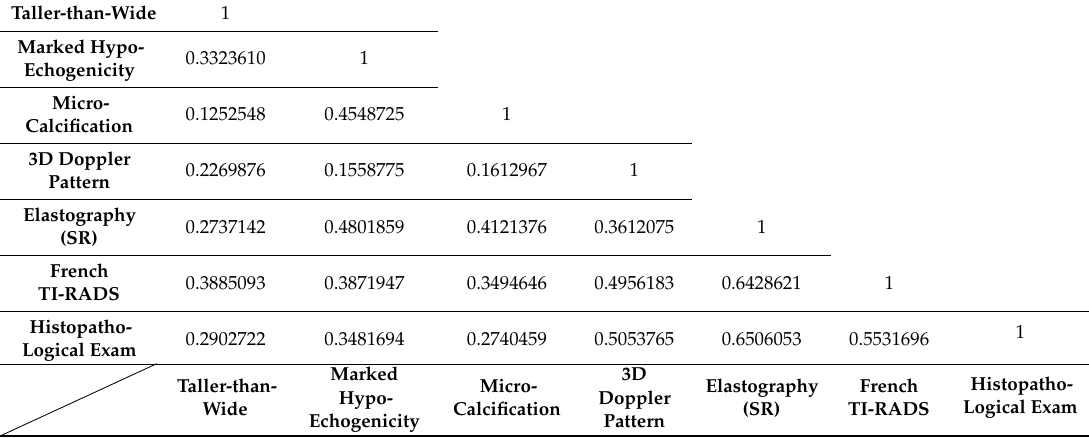
Table 7. Correlation matrix of the